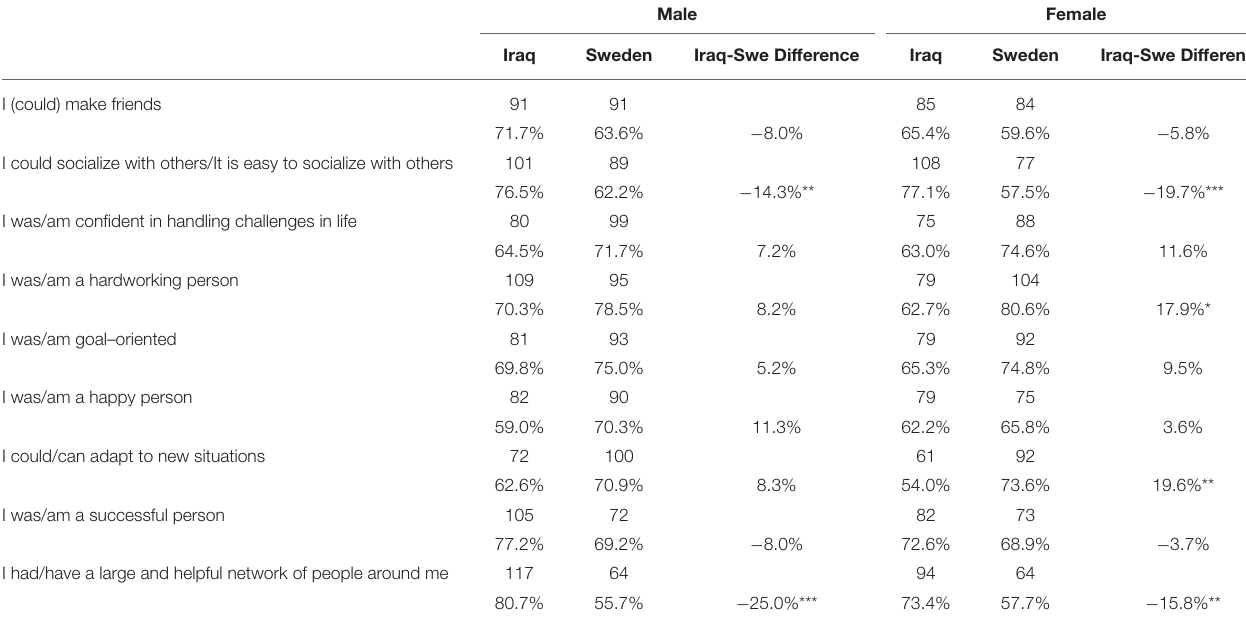
TABLE 7 | Frequency and percentage for self-assessment in personal and social areas and goals in life, by gender and by country ( N = 410). Male Female Iraq